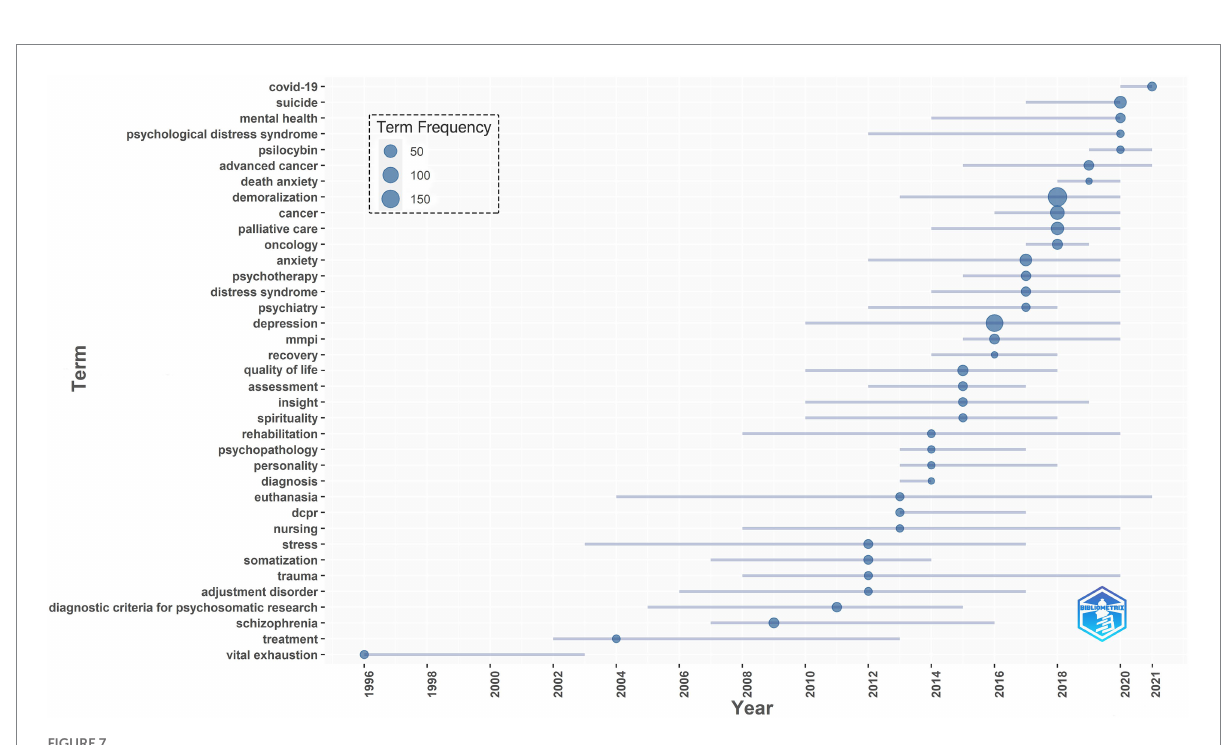
FIGURE 7 Research hot spots for annual outbreak